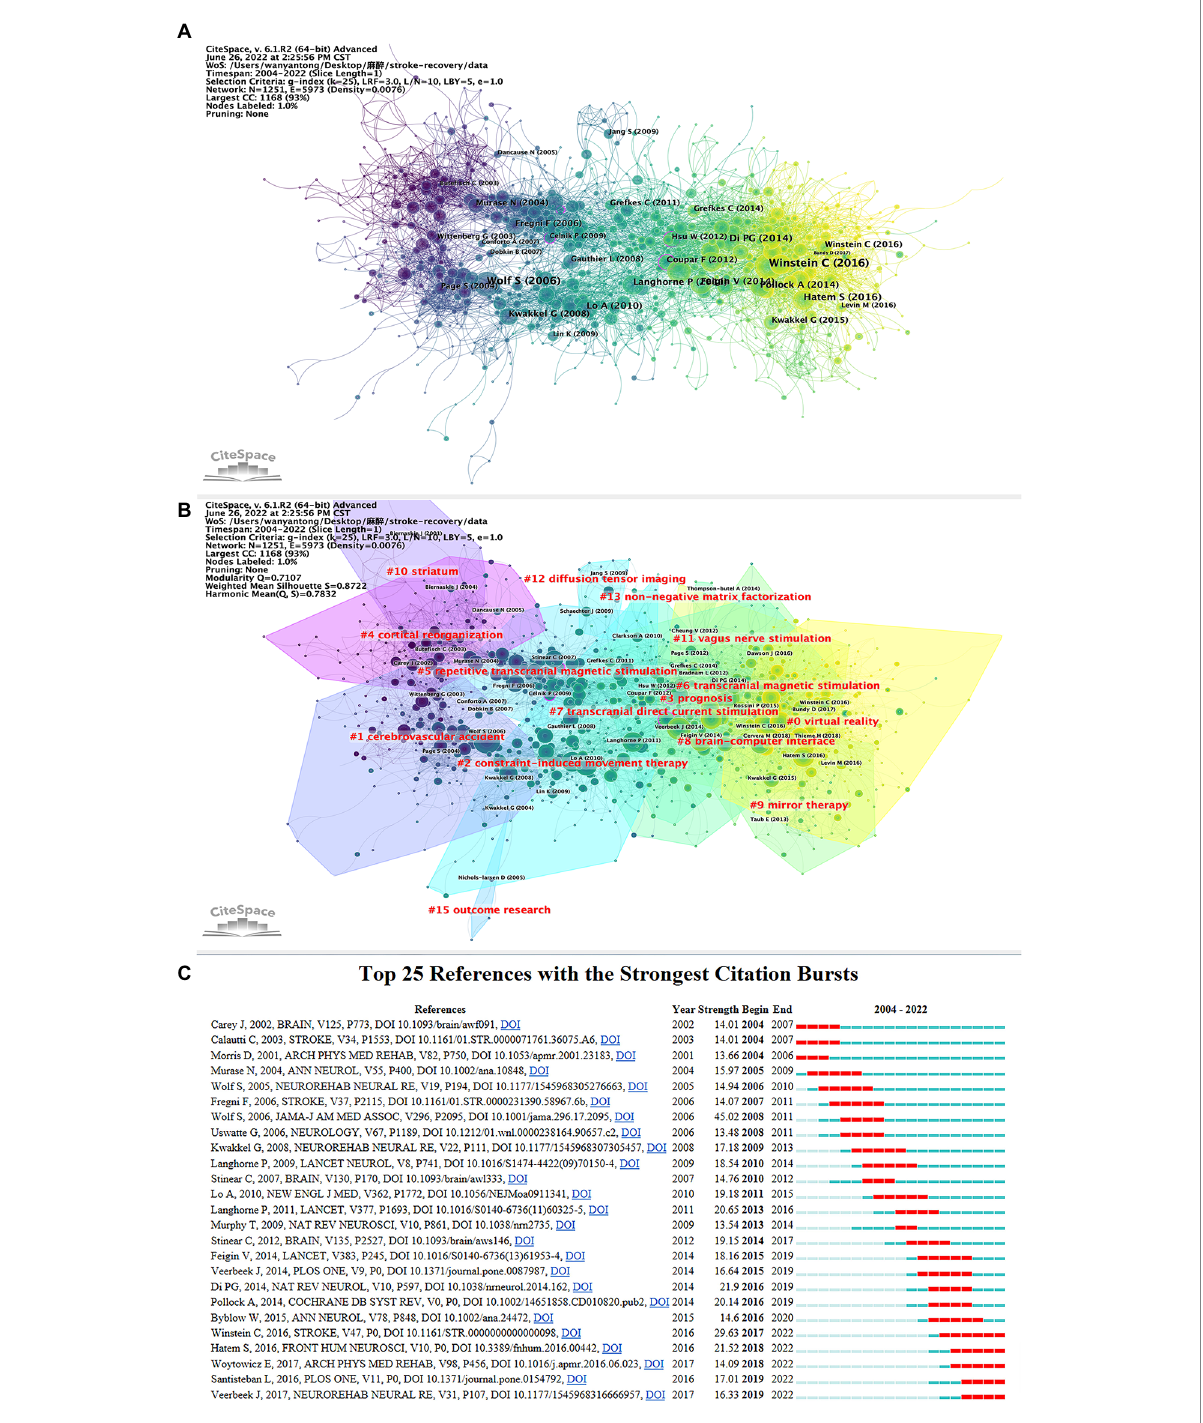
FIGURE 7 (A) Co-cited references related to stroke motor function rehabilitation; (B) cluster view of co-cited references in stroke motor function rehabilitation research; (C) CiteSpace visualization map of top 25 references with the strongest citation bursts involved in stroke motor function